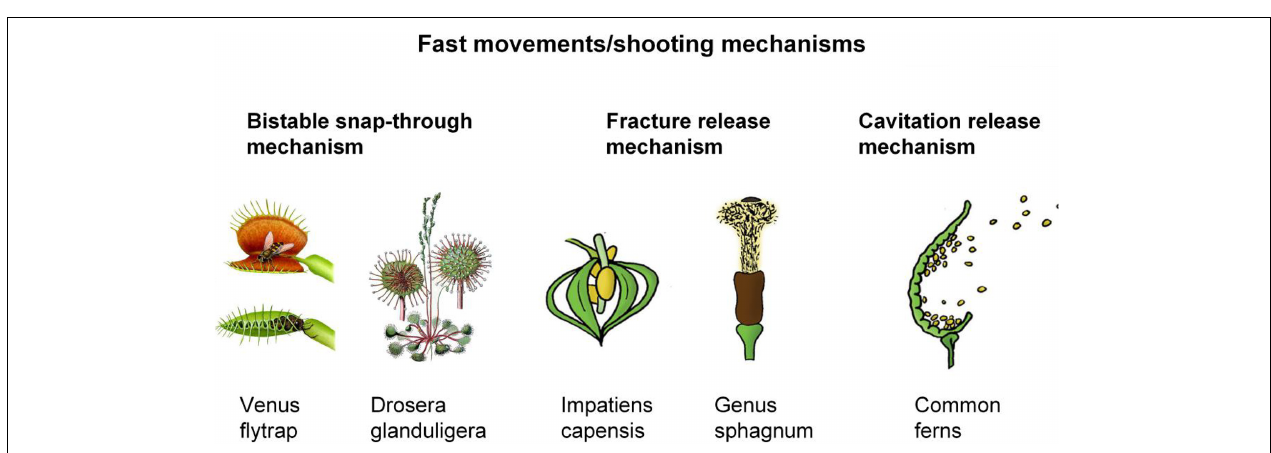
FIGURE 2 | The three structural strategies of actuation in the plant system (cell organization, anisotropic reinforcement, and mechanic instabilities).